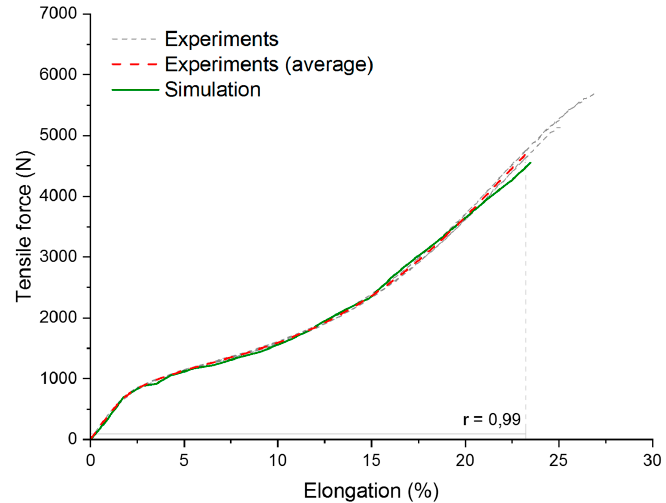
Figure 10. Validation of membrane material model (with correlation coefficient r).